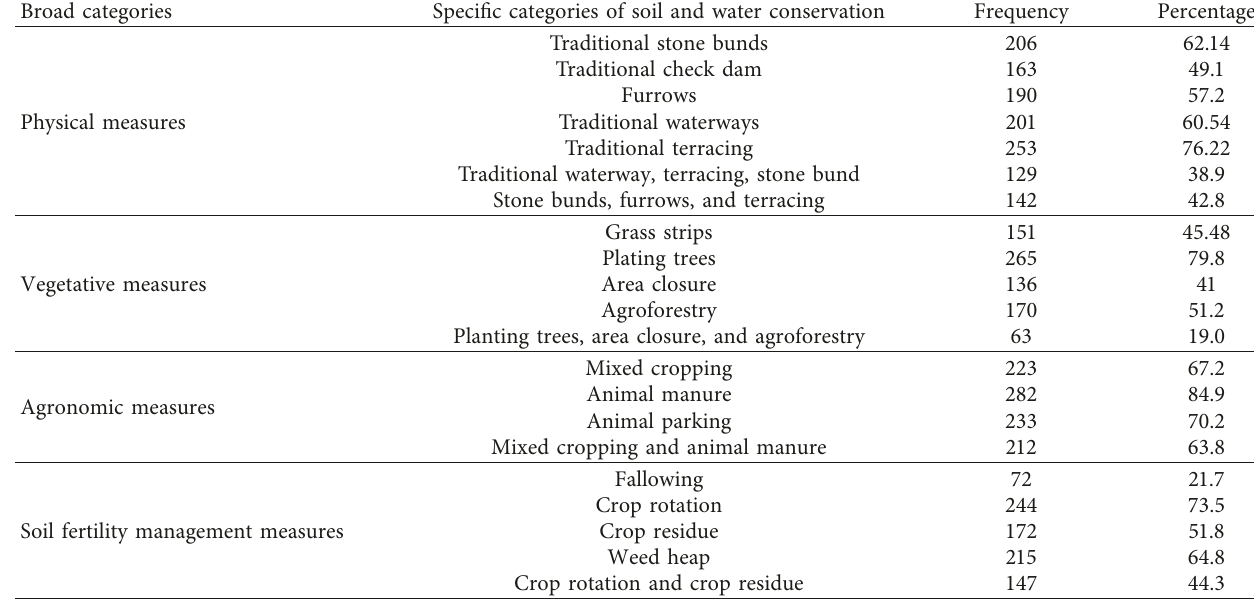
Table 3: The traditional soil and water conservation measures used in the study area.